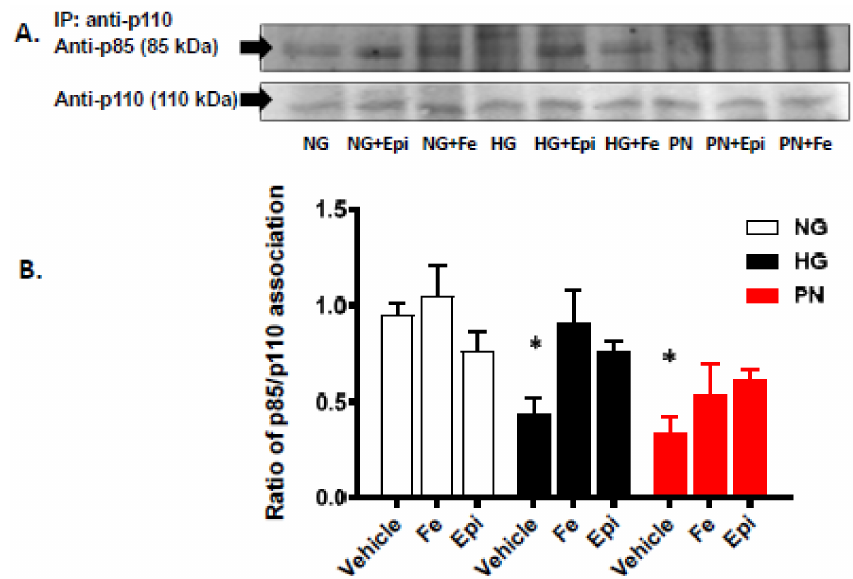
Figure 3. High glucose and peroxynitrite inhibit association between p85 and p110 subunits of PI3- kinase. ( A ) Representative blot of the catalytic subunit (p110) immunoprecipitation showing protein–protein interaction between p110 and the regulatory subunit (p85) that was decreased under high glucose (HG, 25 mM) for 3 days, or peroxynitrite (PN, 0.5 mM) overnight, as compared to normal glucose (NG, 5 mM) but restored back in the presence of FeTTPs (Fe, 2.5 µ M) or epicatechin (Epi, 100 µ M). ( B ) Statistical analysis of the ratio of p85 subunit and p110 subunit using two-way ANOVA showed significant impact of apoptotic insult and also for treatment compared to insult. EC cultures treated with HG or PN showed significant decrease in association of p85 subunit and p110 subunit compared to NG. The association between p85 and p110 was restored in cultures co-treated with the specific peroxynitrite decomposition catalyst FeTTPs (Fe, 2.5 µ M) or the nitration inhibitor epicatechin (Epi, 100 µ M) (* p < 0.05 versus vehicle, significant using Bonferroni test compared to the rest of the groups, n =